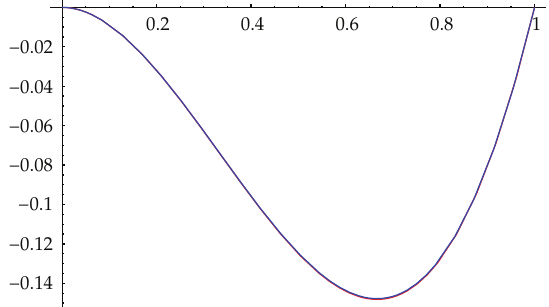
Figure 2: The approximate values U 2 (cid:2) x (cid:3) in comparison with its exact values x 2 (cid:2) x − 1 (cid:3) .